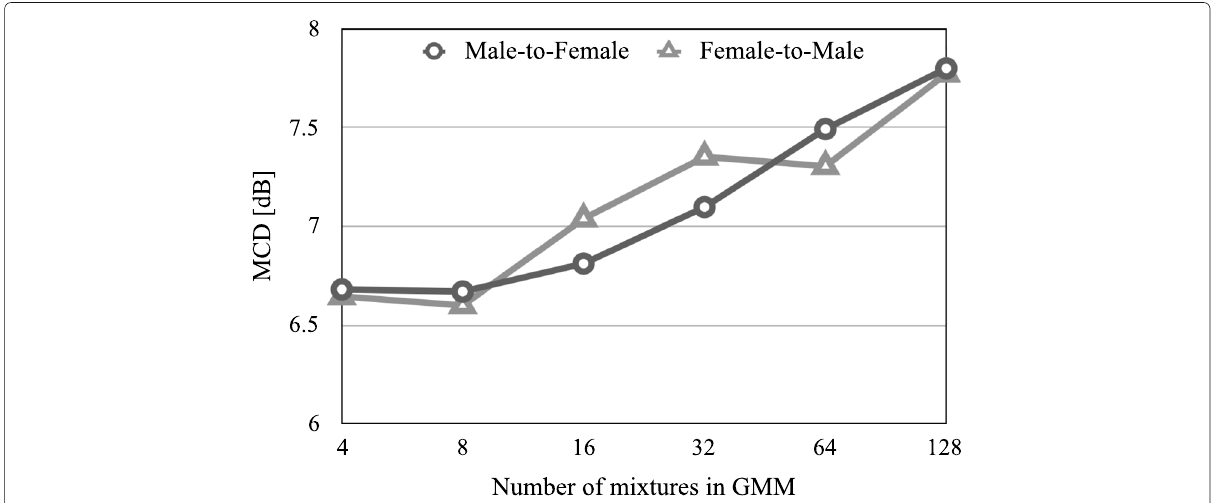
Fig. 3 Average MCD [dB] of the conventional GMM-based VC when varying the number of mixtures